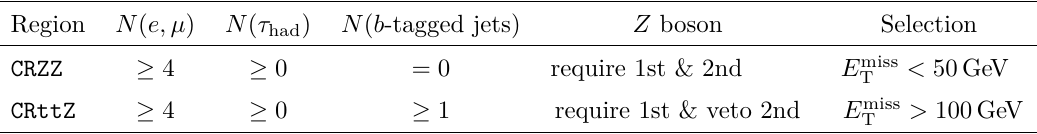
Table 5. Irreducible background control region definitions. Both CRZZ and CRttZ are restricted to N ( e, µ ) = 4 when considering SR5L . The Z boson column refers to the Z veto or selection of a first/second Z candidate as described in the text.